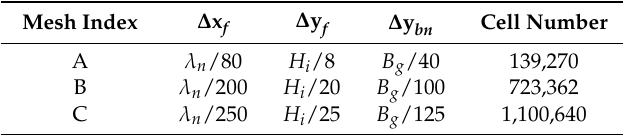
Table 2. The three di ff erent grid resolutions used in the present